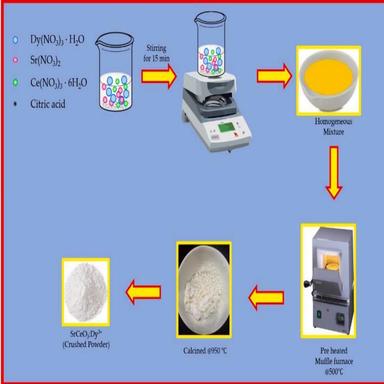
Schematic representation of the synthesis process used to fabricate SCD1-9 NPs.